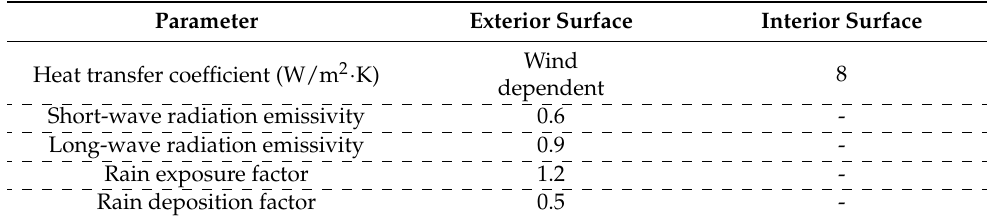
Table 7. Boundary conditions of the internal and exterior